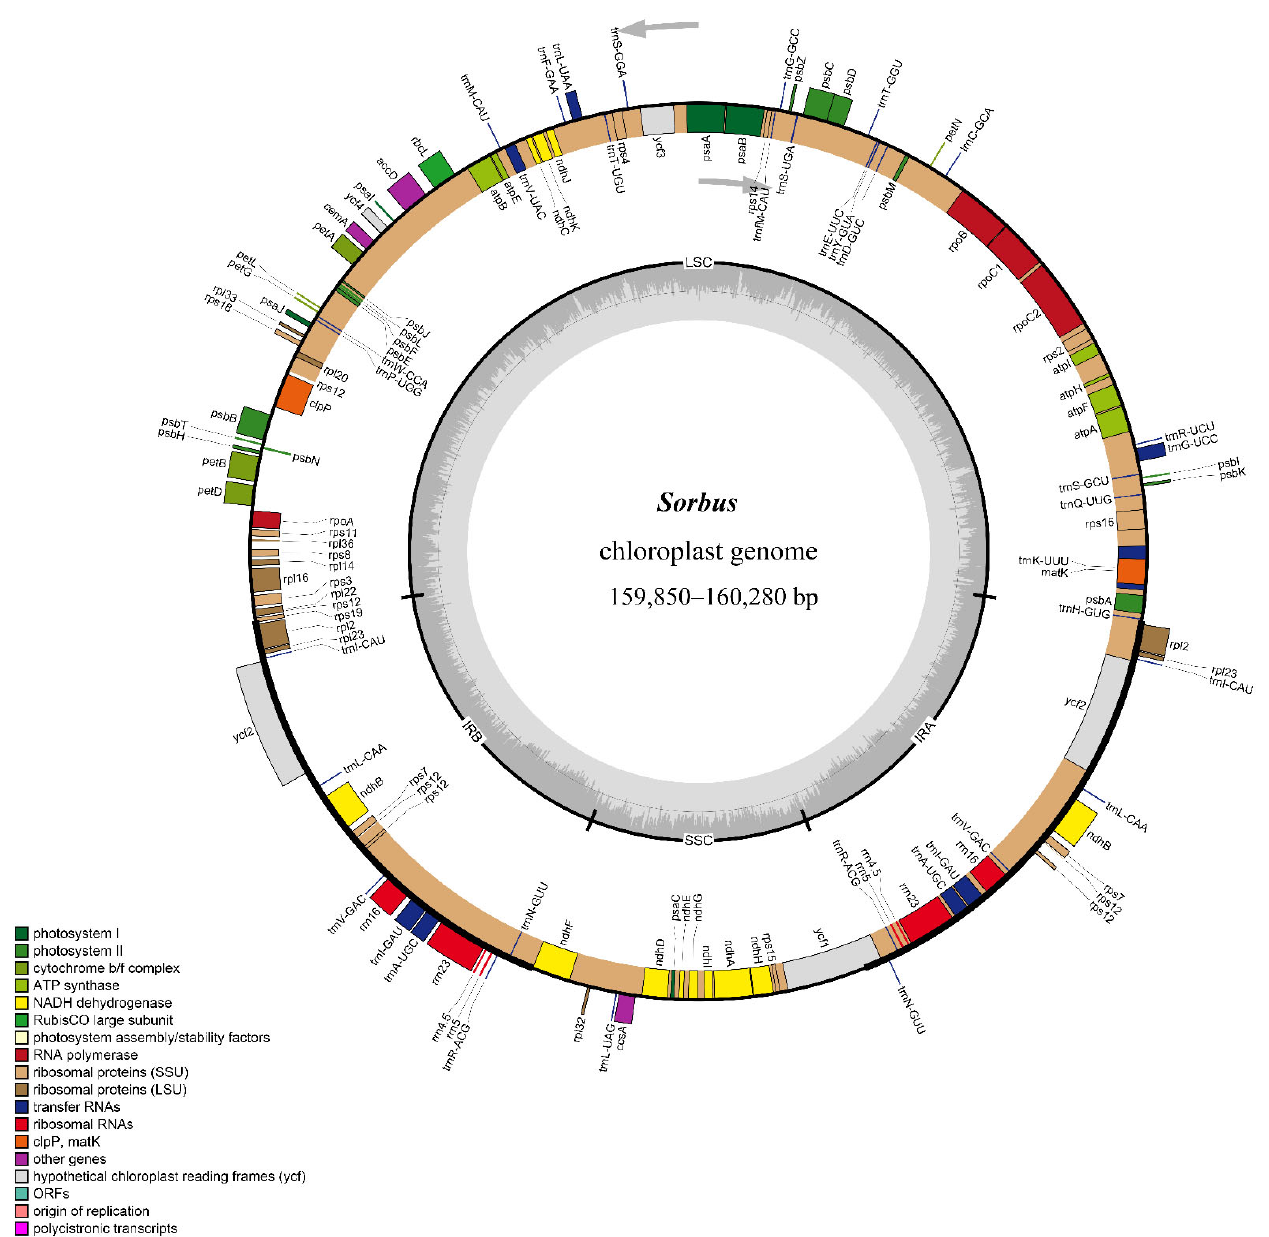
Figure 1. Chloroplast genome map of Sorbus . The inner grey circle indicates the GC content of each genome position. Genes in the inner circle of the genomic map are transcribed clockwise and vice versa. Table 1. Summary of complete plastomes of Sorbus species.